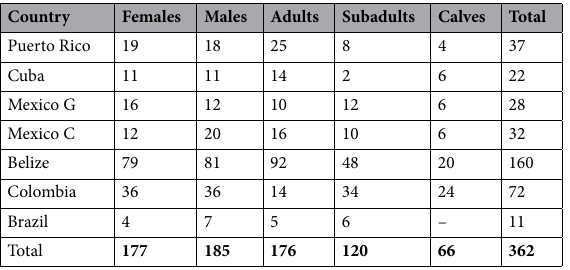
Table 1. Details on sex and age class of wild Antillean manatees captured for health assessments or rescues in seven locations throughout their range. Mexico C = Mexican Caribbean, Mexico G = Southern Gulf of